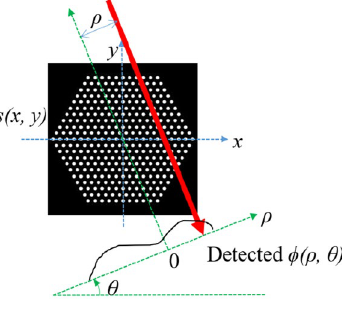
Figure 13. The tomography measurement of the fuel assembly at an angle θ . The counts of detector (ρ , θ) can be approximated by the integral of the source distribution s ( x , y ) along the red line that passes through the detector